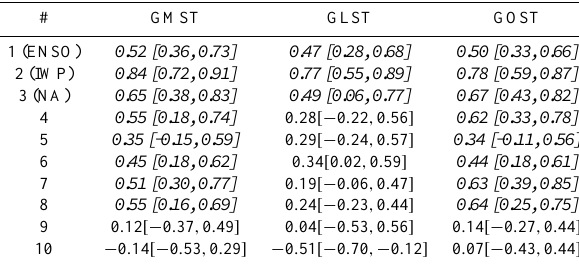
Table 2. Correlations between the mean time series of the com- munities of the H-SST-LP8y network and the indices of mean, land and ocean surface temperatures (all time series 8y low-pass filtered). The 95% confidence intervals are given in brackets and correlations significant at 5% in italic